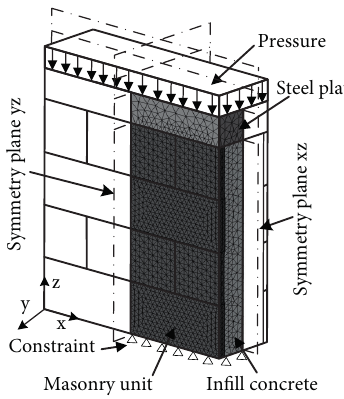
Fig. 6. Numerical masonry fragment